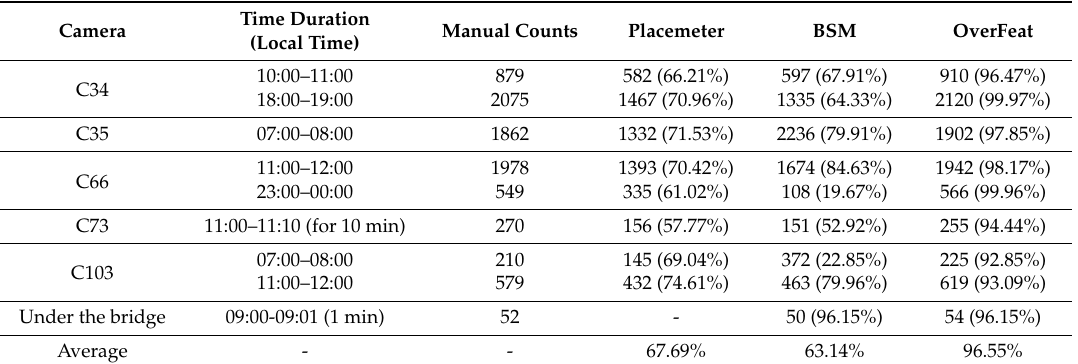
Table 2. Accuracy assessment of the